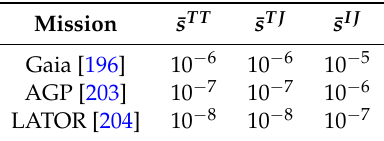
Table 10. Sensitivity of the SME coefficients to the measurement of the light deflection by several space missions or proposals (these estimates are based on Table I from